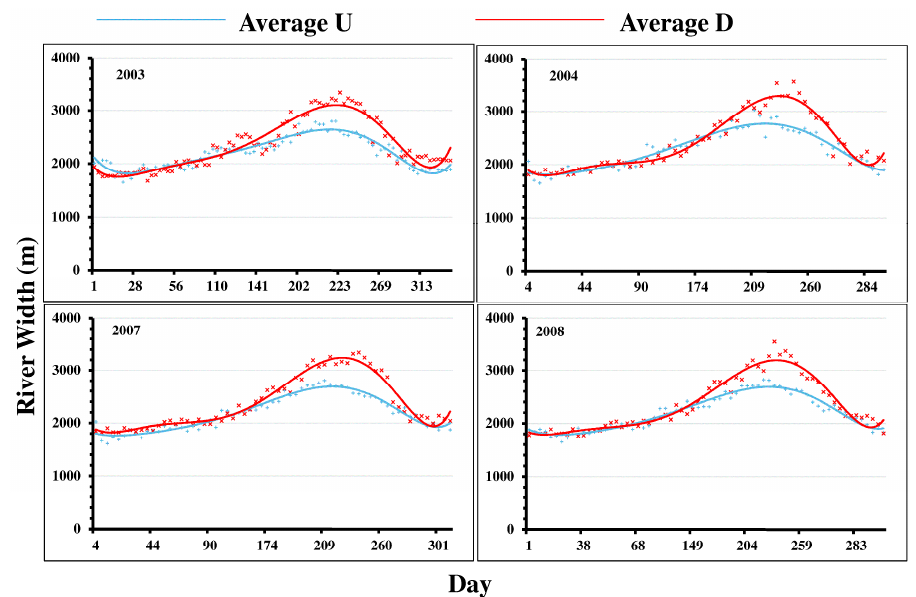
Figure 9. Illustration of the overlap between the temporal river width at stations A and B, as illustrated in Figure 8.